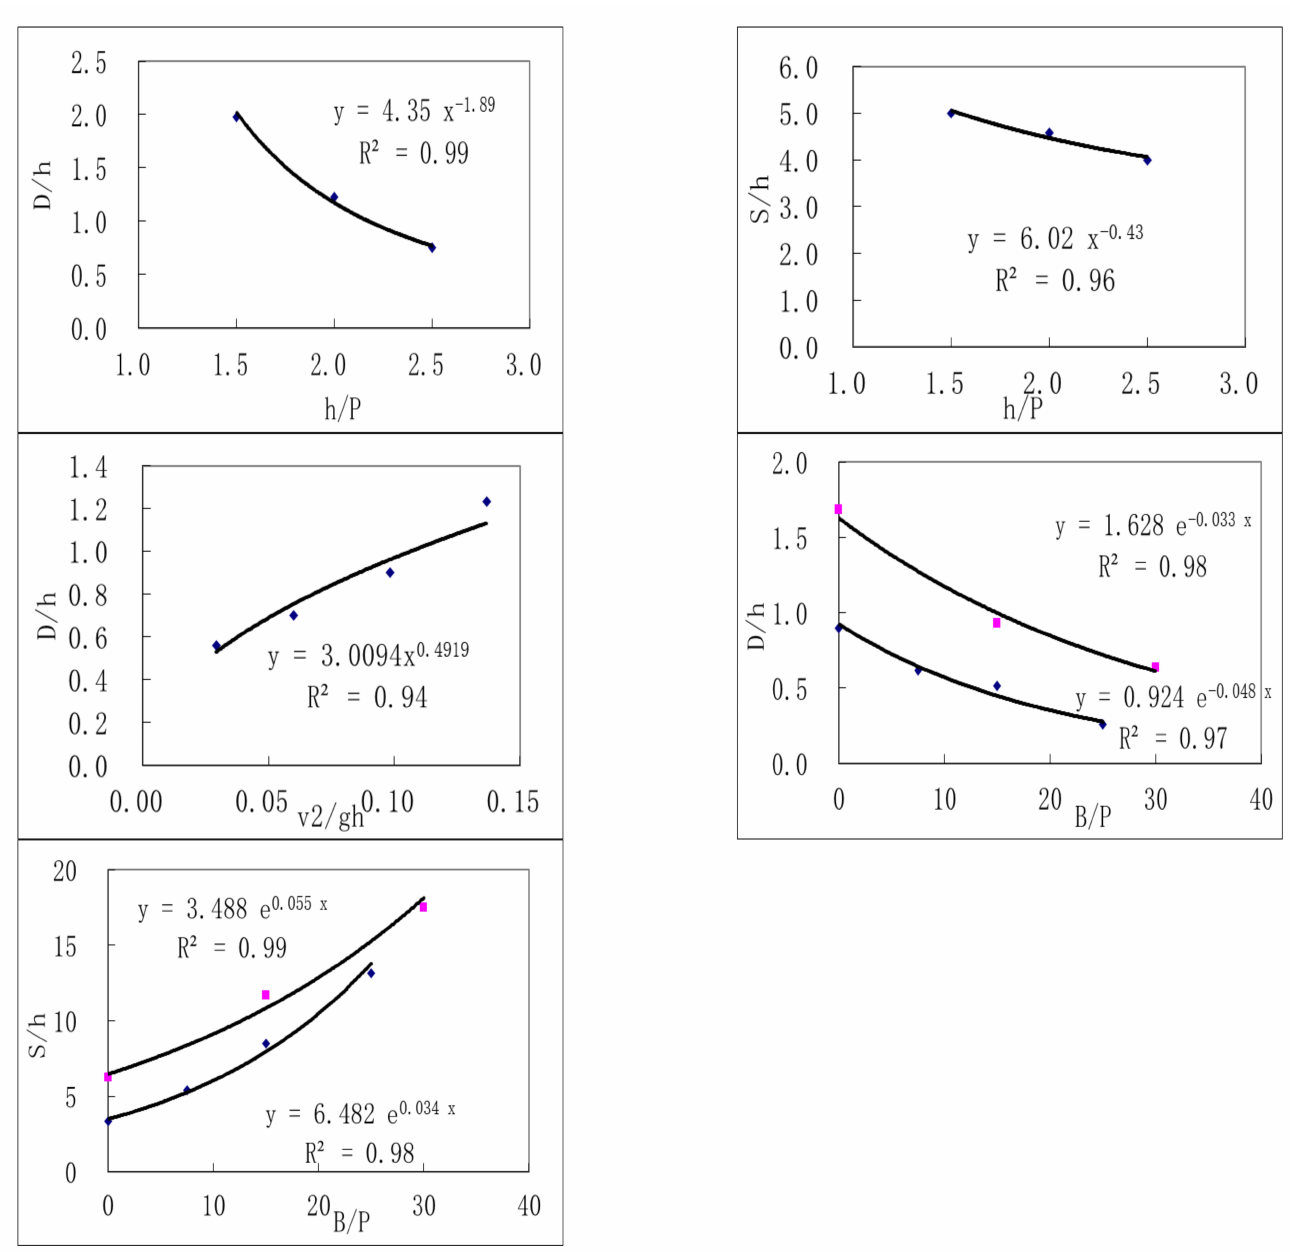
Figure 8. Single-factor fitting